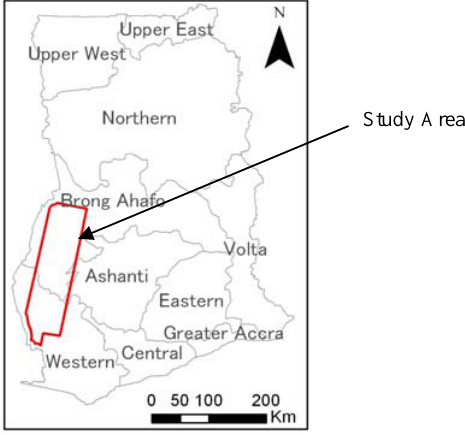
Figure 1. Map of Ghana Showing the Study Area, which Covers the Brong Ahafo, Ashanti and Western Regions and Includes all Major Ecological Zones